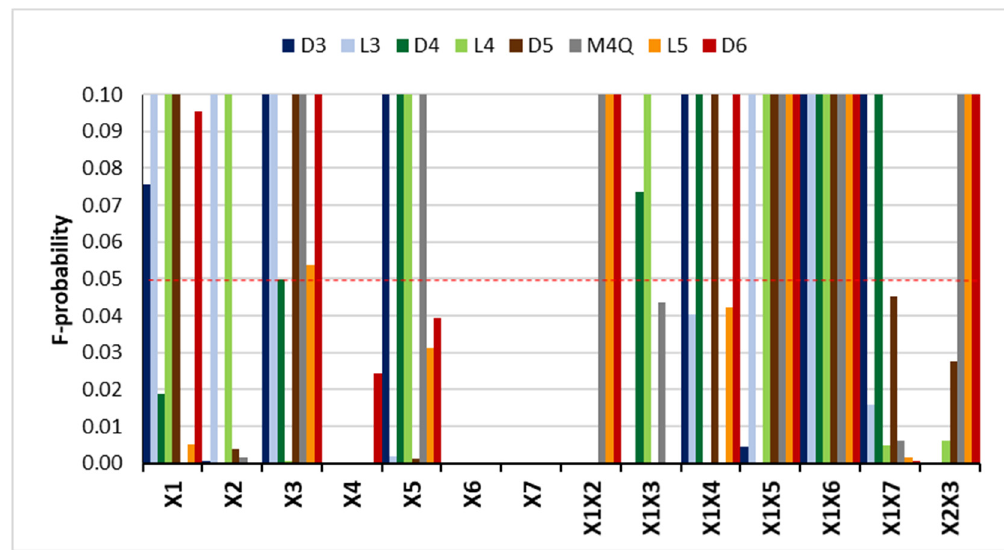
Figure 1. F-probability obtained with screening design.